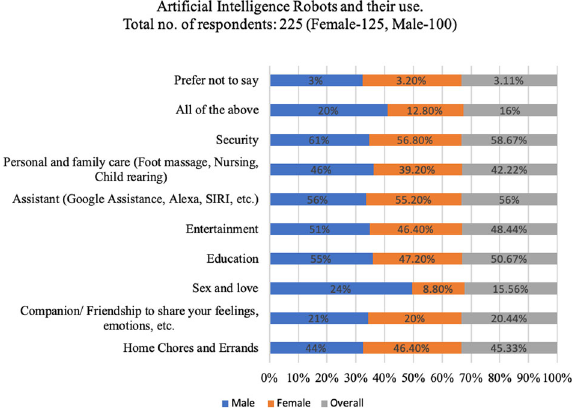
Fig. 8 Arti fi cial intelligence robots and their use. Total no. of respondents: 225 (Female: 125, Male: 100).